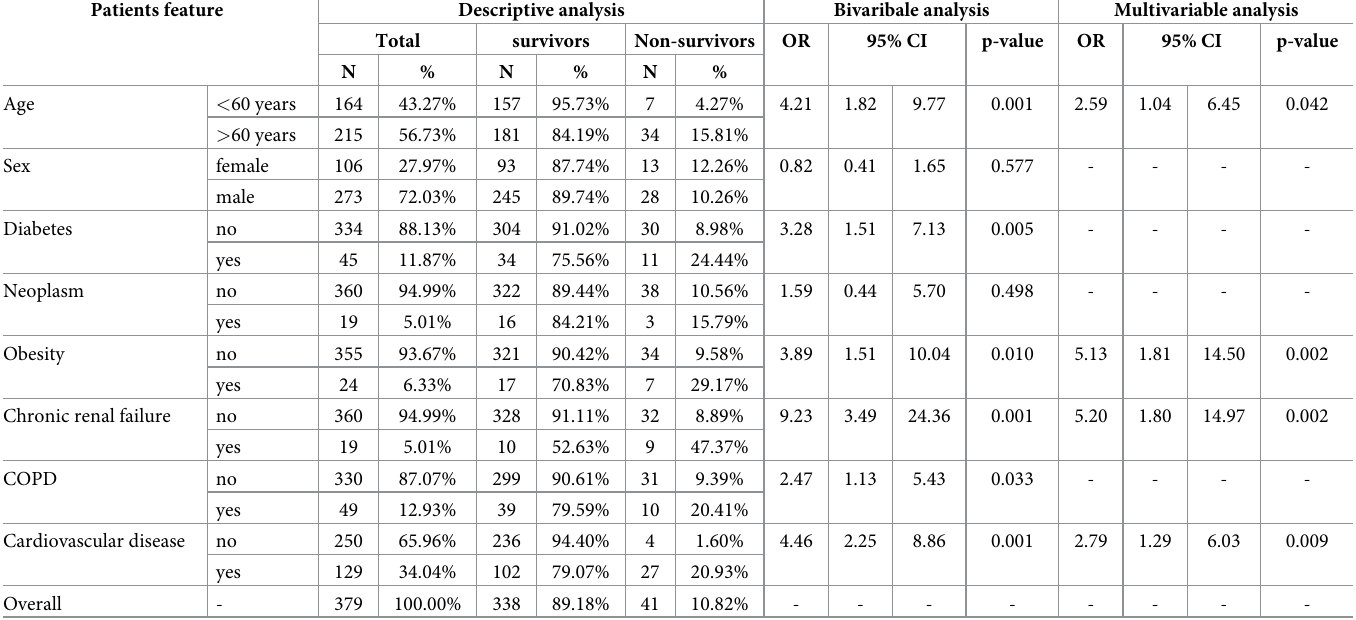
Table 1. Patients’ demographics and